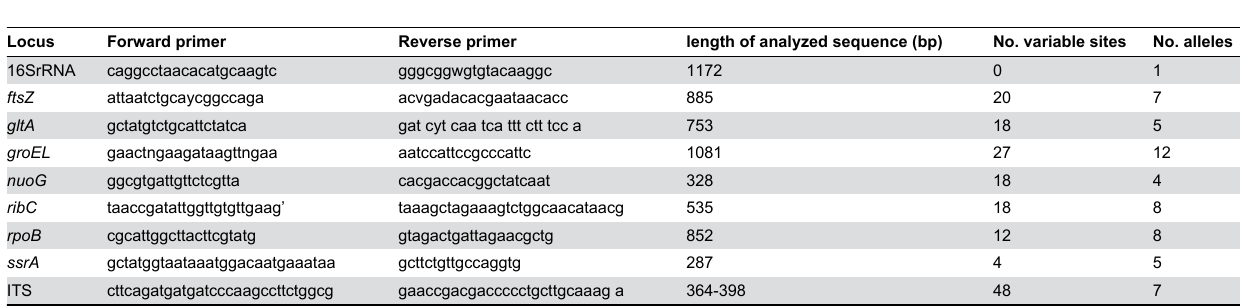
Table 2. Characteristics of the nine loci evaluated for the B. bovis MLST scheme.